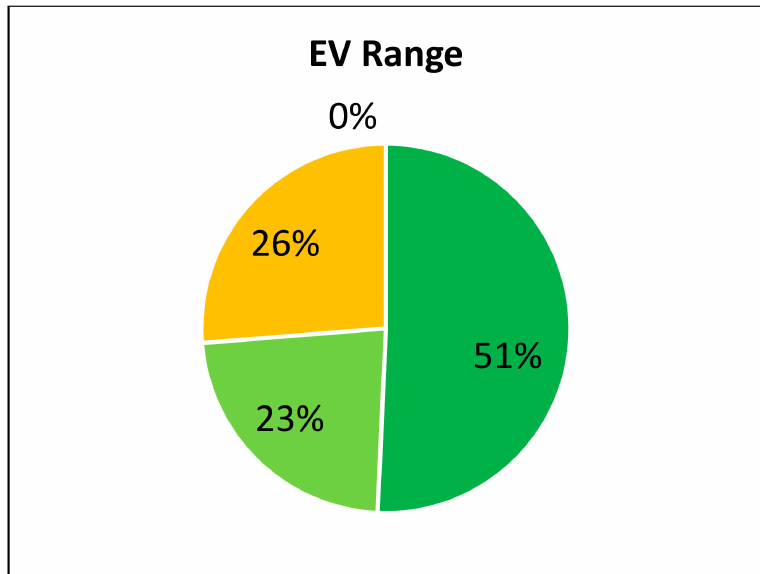
Figure 25. User satisfaction of their EV range.